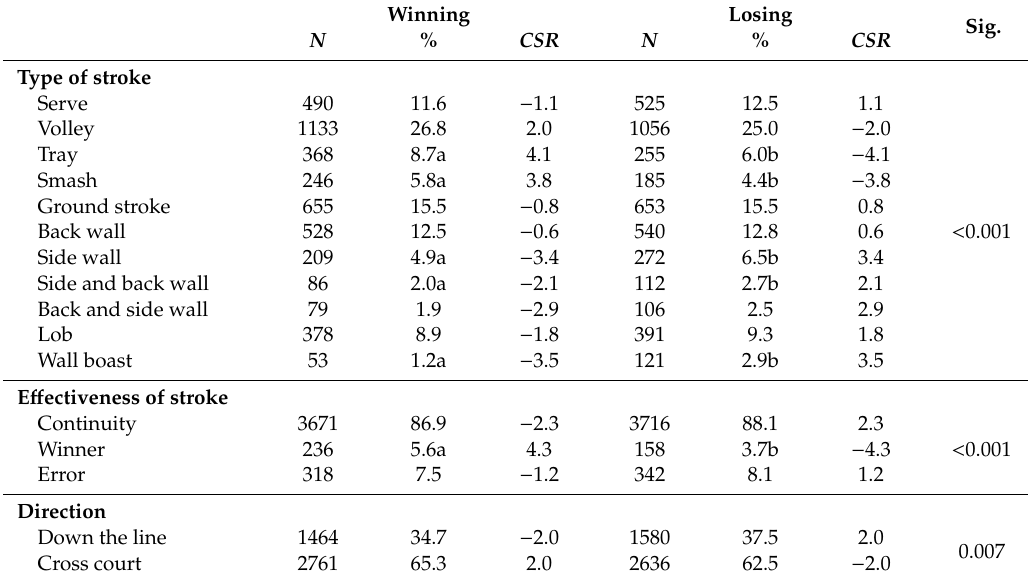
Table 1. Type of stroke, e ff ectiveness, and direction according to match